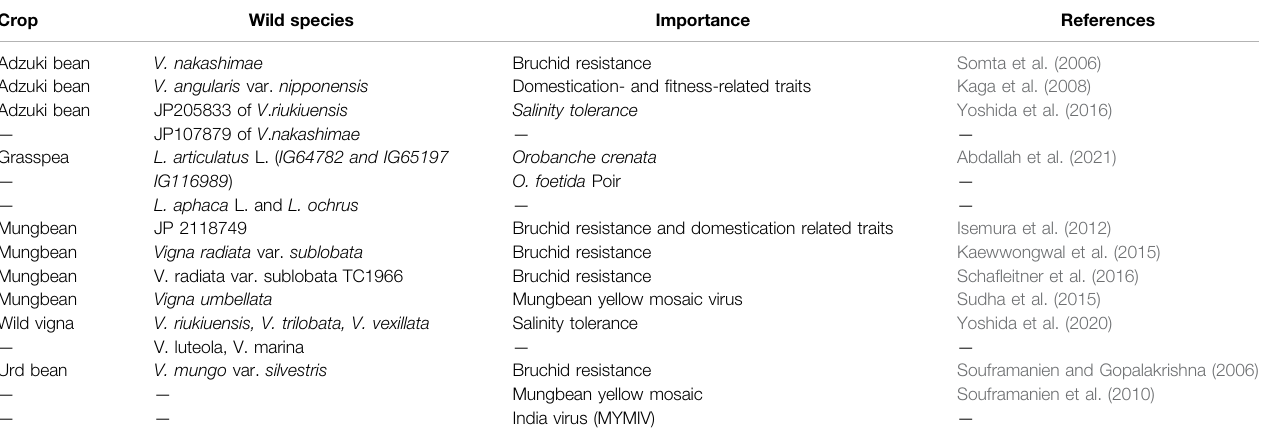
TABLE 5 | List of CWRs source of novel trait gene in various underutilized